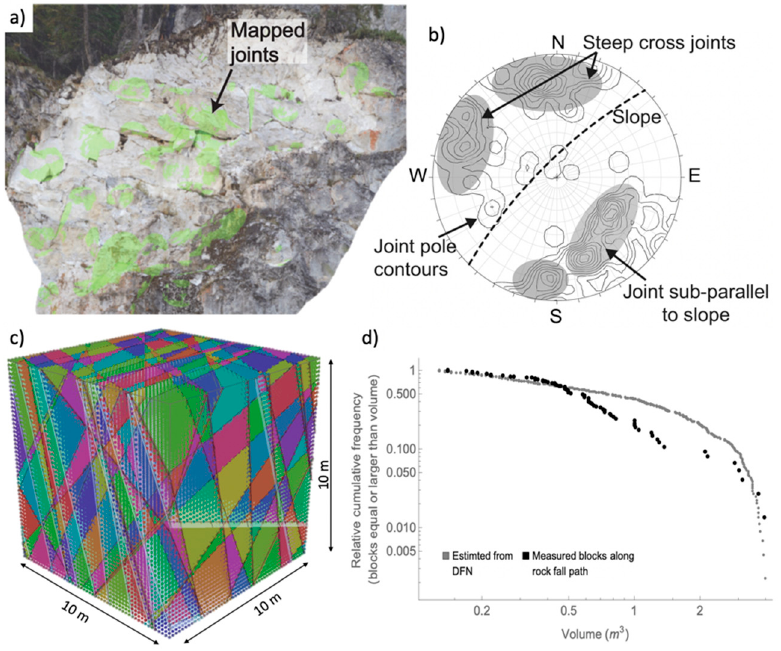
Figure 13. Virtual structural mapping ( a ) and resulting discontinuity sets ( b ) for the Tornado Mountain study site. One iteration of the DFN for the Tornado Mountain site ( c ). fragmented rock fall volume cumulative distribution based on the DFN realizations compared to block volumes surveyed along the rock fall trajectories, DFN volumes are truncated to the minimum range of surveyed block volumes for accurate comparison (lack of survey of small fraction of blocks) ( d ). Adapted from [55,56].